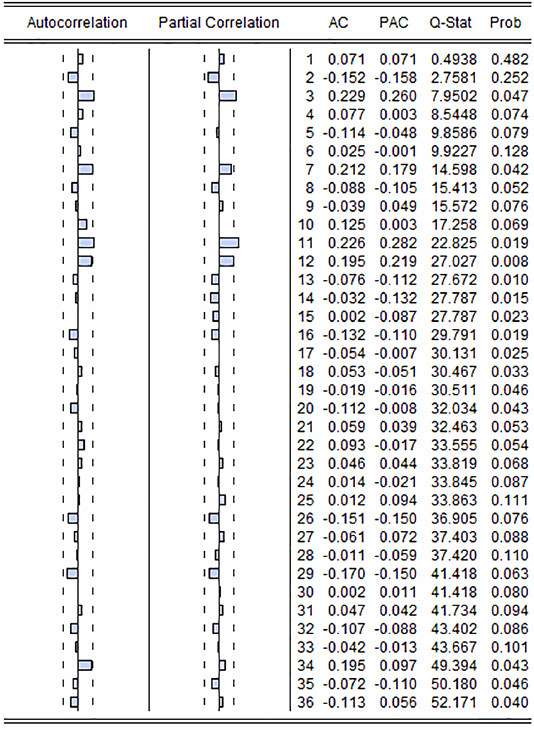
Figure 4. The correlogram graph of the series in the first